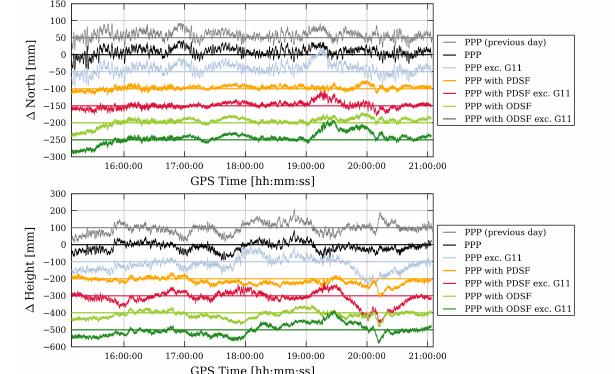
Figure 10: Northing (top panel) and height (bottom panel) errors between 15:17 and 21:04 (GPS system time) on August 31 2013 for receiver UEL resulting from standard PPP processing both with (black) and without (blue-grey) measurements from the satellite G11 on day 2. Similarly shown in other colors are the errors resulting from PPP processing with position- or observation-domain sidereal filters applied. Each of the time series have been offset from each other by appropriate multiples of 50 mm or 100 mm for